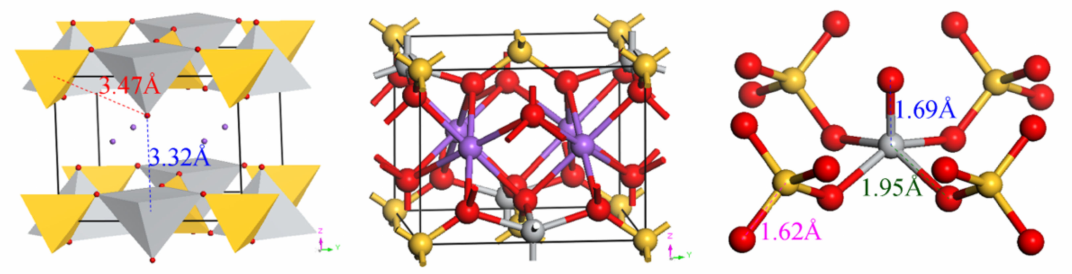
Figure 3. Polyhedral structure and ball-and-stick structure of natisite and O = Ti–(O–Si) 4 unit. Purple, Na; gray, Ti; yellow, Si; red, O.